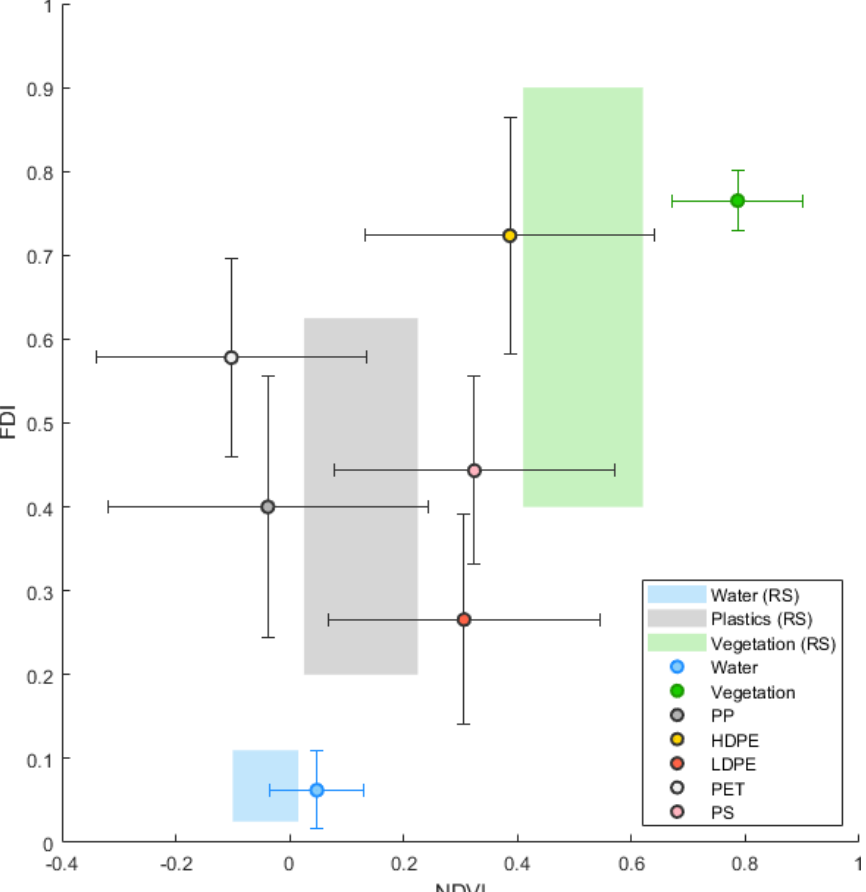
Figure 8. FDI and NDVI scatter for all seven classes with their mean value (coloured dots) and standard deviation as error bars. The opaque blue, green, and grey boxes represent the range of scattered values as analysed in Biermann, Clewley, Martinez-Vicente and Topouzelis